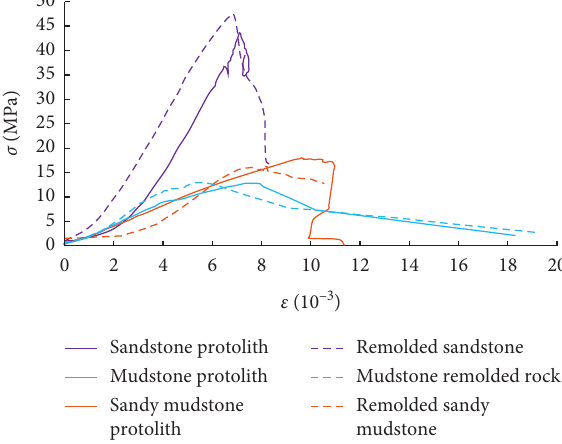
Figure 2: Comparison of mechanical properties of different proto- rock and remolded rock